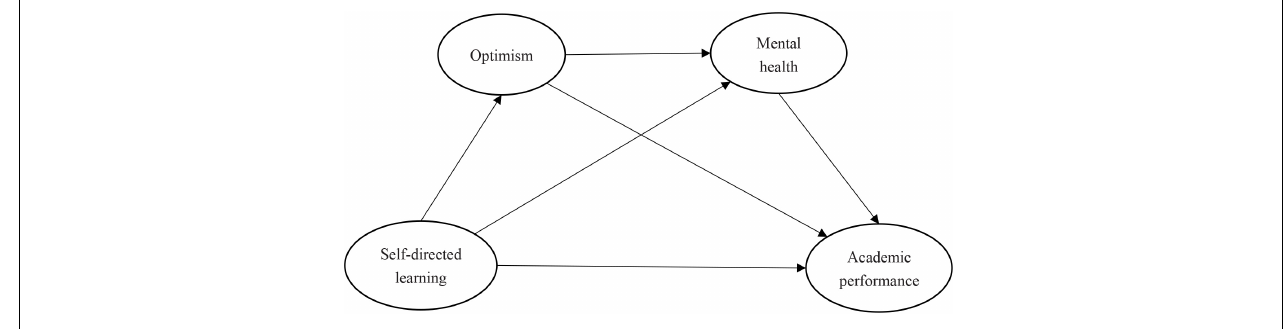
FIGURE 1 | Hypothetical model.